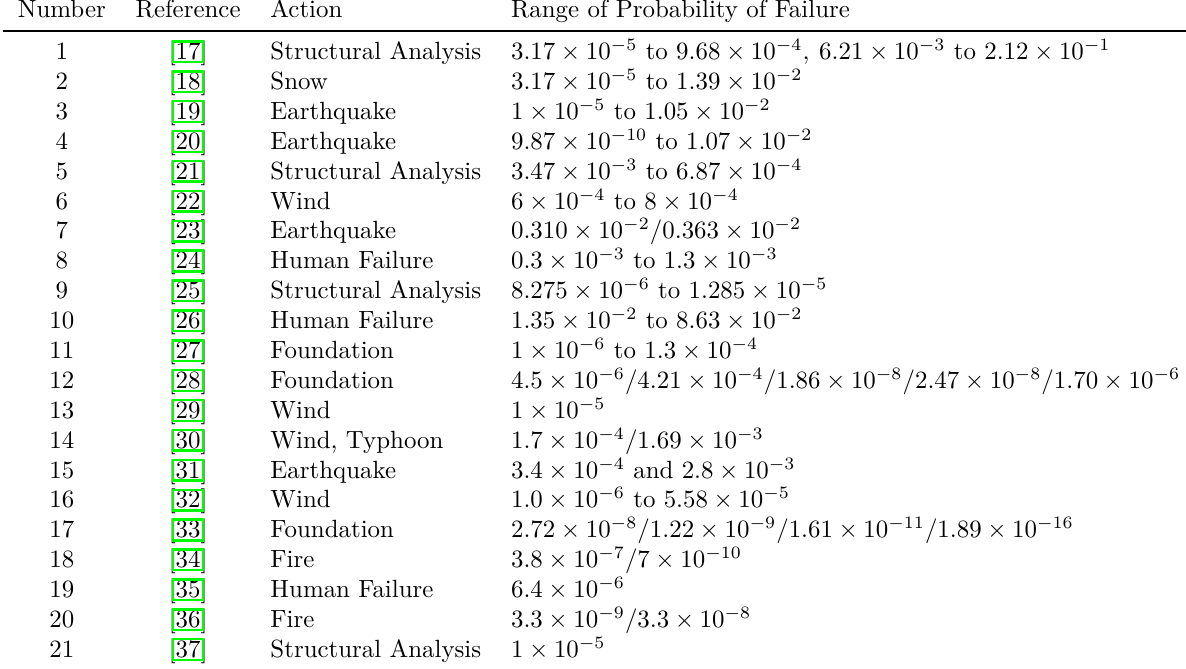
Table 1. References and related Probabilities of